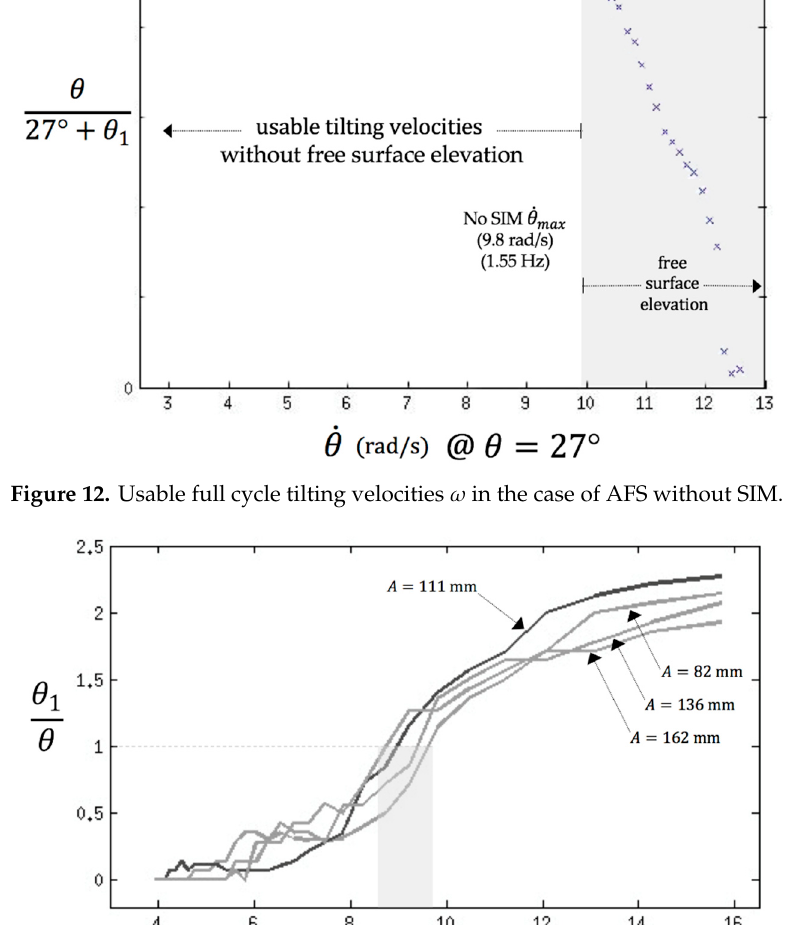
Figure 12. Usable full cycle tilting velocities ω in the case of AFS without SIM.